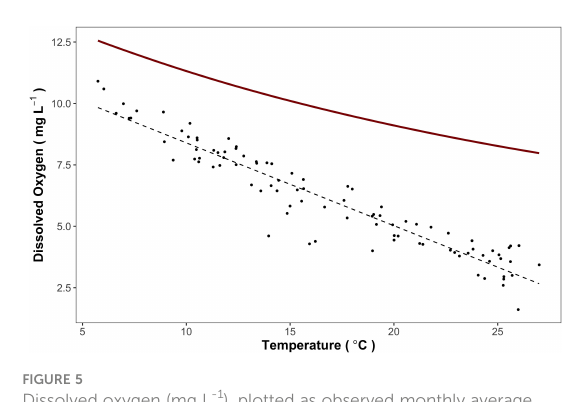
FIGURE 4 Continuous monitoring data from 2010 – 2020 including: Daily average water temperature (°C; fi lled grey region) and daily minimum dissolved oxygen concentrations (mg L -1 ; solid black line); the red line indicates the threshold of dissolved oxygen impairment as de fi ned by a daily minimum oxygen concentration < 4.0 mg L -1 set by the South Carolina Department of Health and Environmental Control (SCDHEC, 2014). Dashed black lines indicate the start of the annual cycle in January. Data gathered from Waccamaw River at Hagley Landing (USGS site number 2110815).